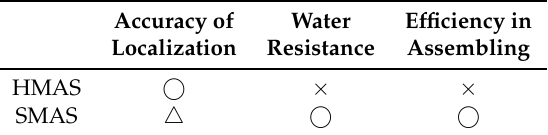
Table 1. Pros and cons of the HMAS and the SMAS.